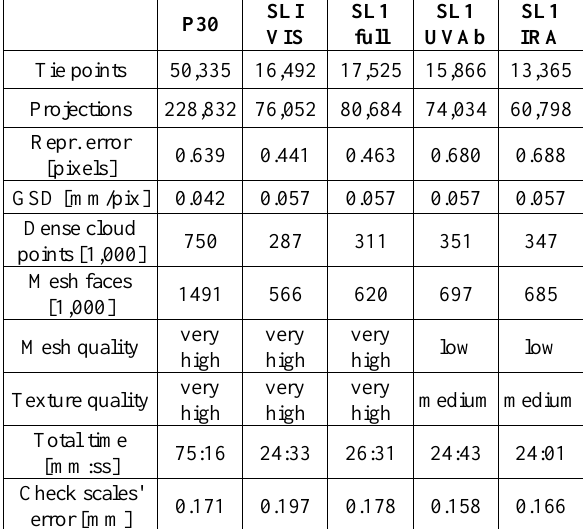
Table 7: 3DFlow Zephyr results